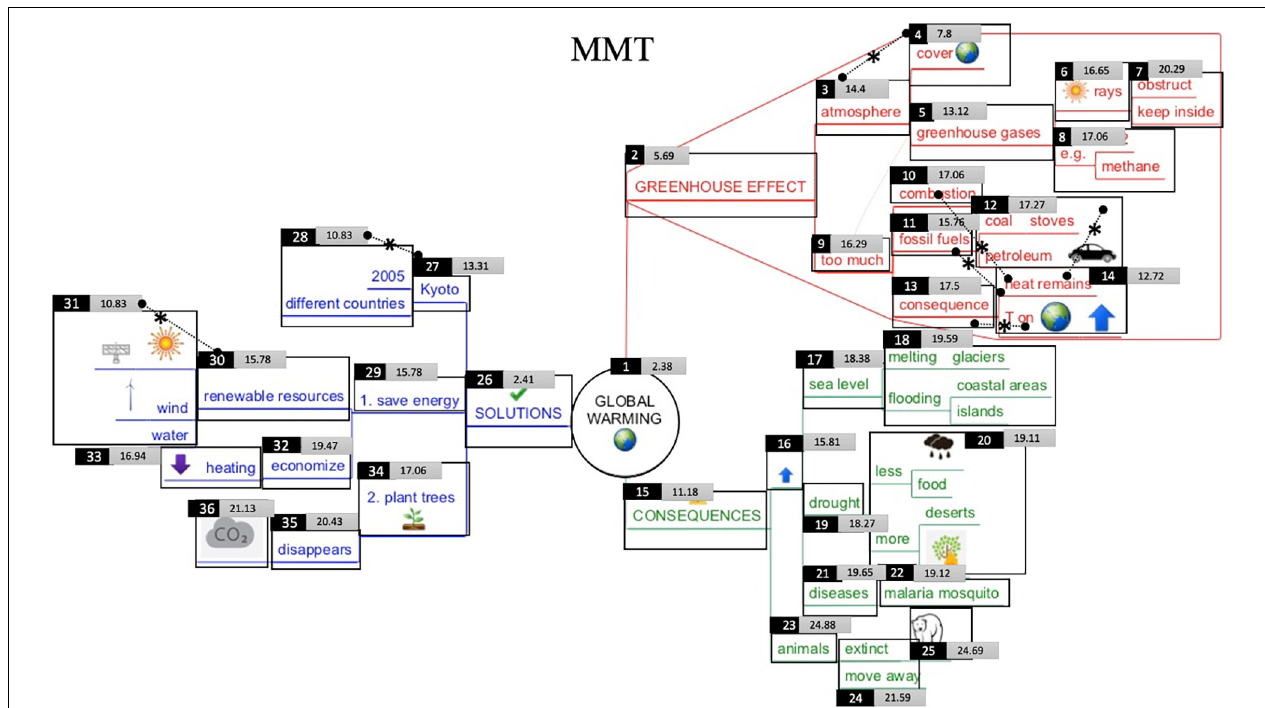
FIGURE 7 | Visualization of students’ early attention in the Mind Map-Text condition (MMT). The smaller the number in the light gray rectangle, the earlier attention that particular Interest Area received in the first-pass reading process. Interest Area number is located at the upper left of the IA. Level-1 branches = IA 2–15–26; level-2 branches = IA 3–9–16–23–27–29–34; level-3 branches = IA 4–5–10–11–13–17–19–21–24–28–30–32–35; level-4 branches IA 6–7–8–12–14–18–20–22–25– 31–33–36. Dotted lines with asterisks indicate significant differences in early attention between